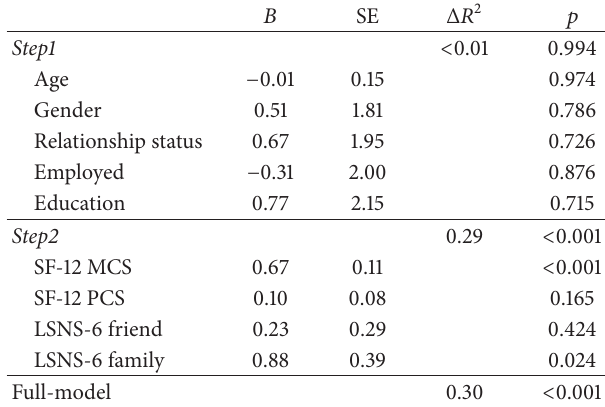
Table 3: Regression results of resilience status on covariates and independent variables ( 𝑁 = 198 ).